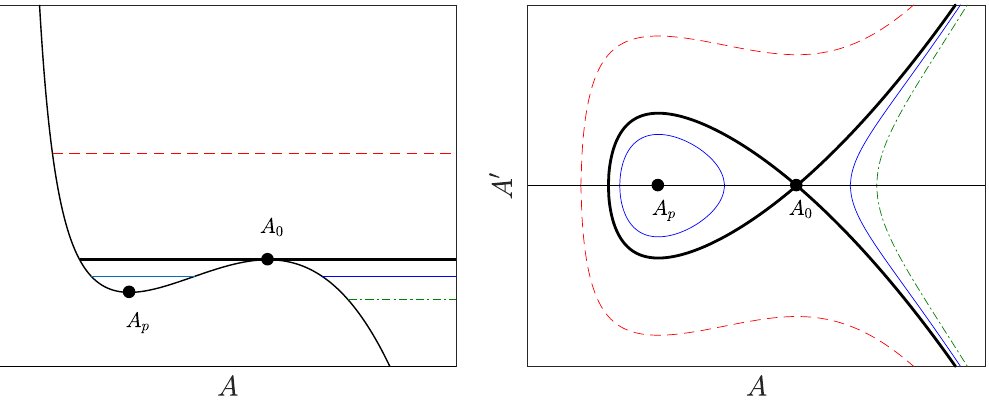
Figure 2. Left plot: representation of the amplitude potential W ( A ) (black solid line). We depict some values of the amplitude energy E A corresponding to qualitatively different solutions; E A = W ( A 0 ) is plotted in the black thick line; W ( A p ) < E A < W ( A 0 ) is plotted in the solid blue line; E A > W ( A 0 ) is plotted in the red dashed line; and E A < W ( A p ) is plotted in the green dashed-dotted line. The homogeneous solutions A = A 0 and A = A p are marked with a black dot. Right panel: orbits in the space ( A , A (cid:48) ) associated with the values of the amplitude energy shown in the left panel, which can be obtained from the relation A (cid:48) 2 = 2 [ E A − W ( A )] . The horizontal black line marks A (cid:48) =